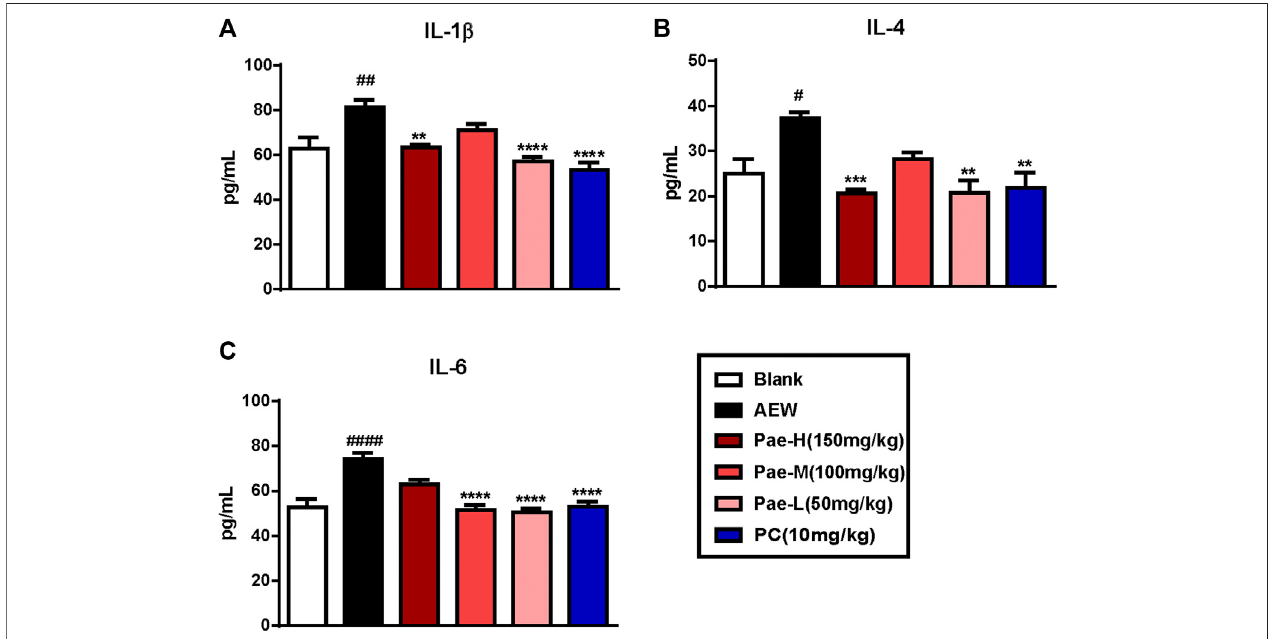
FIGURE3| Paeonolreducedproteinlevelsofpro-in fl ammatorycytokinesintheserumofAEWmice. (A – C) AdministrationofpaeonoldecreasedthelevelsofIL-1 β (A) , IL-4 (B) , IL-6 (C) in the serum of AEW-induced mice. Data were expressed as mean ± SEM. # p < 0.05, ## p < 0.01, #### p < 0.0001, compared to the blank group; pp p < 0.01, ppp p < 0.001, ppp p < 0.0001, compared to the AEW model group ( n (cid:1) 4 – 7 each